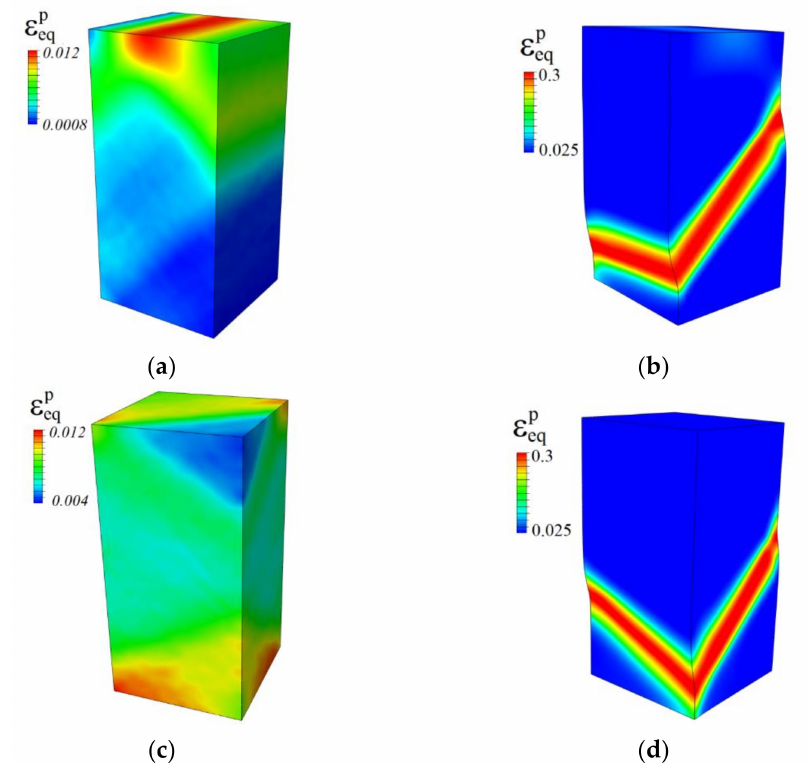
(cid:0) (cid:1) 110 and (001) (the (cid:0) (cid:1) (cid:0) (cid:1) 112 and 111 lateral faces